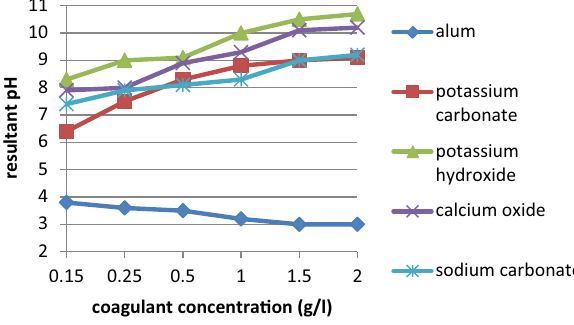
Fig. 9 Resultant pH at varying doses of coagulants (pH